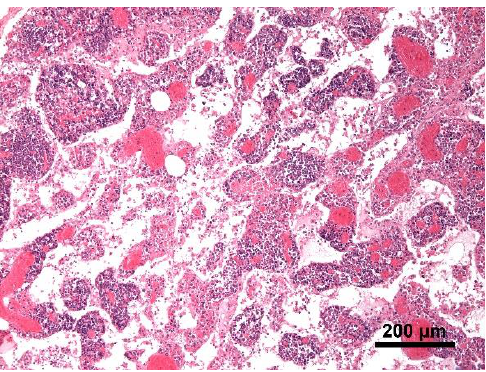
Figure 9. Mediastinal lymph node. The lymph node was microscopically characterized by edema and severe hyperemia; Hematoxylin and eosin stain, 10× magnification.